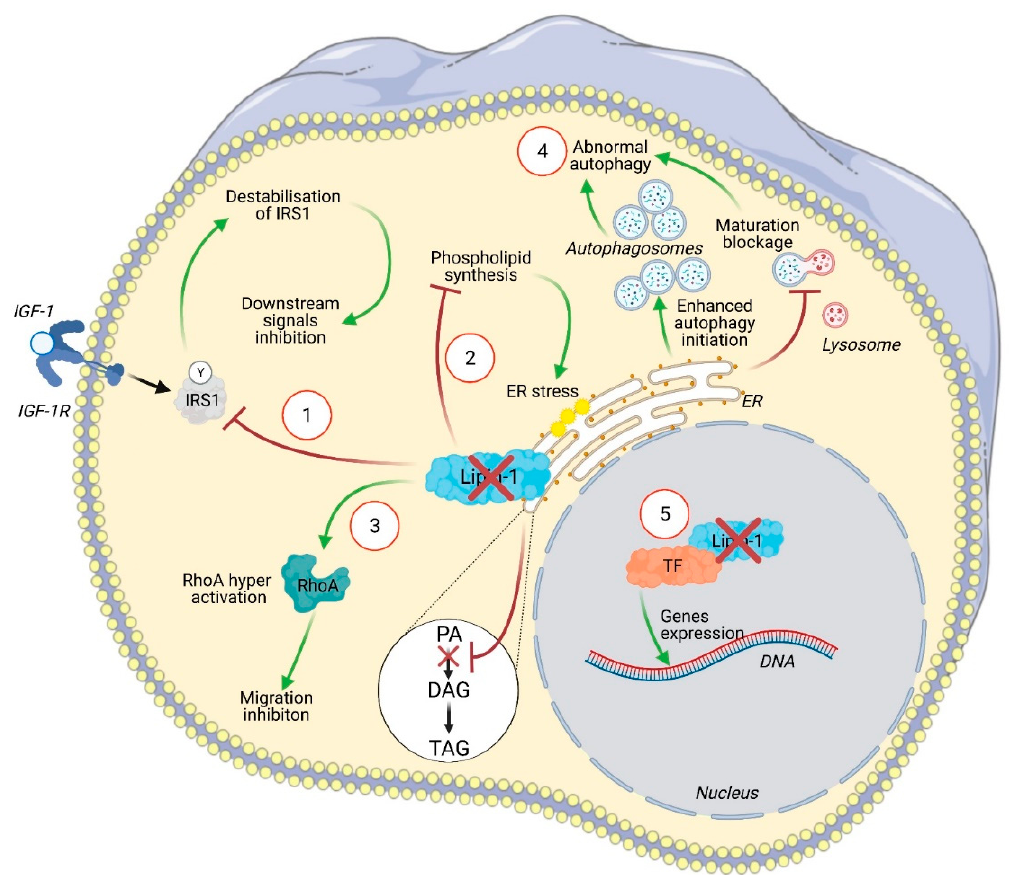
Figure 2. Illustration of the intracellular signaling pathways affected by lipin-1 silencing in cancer cells. In (1), insulin receptor substrate 1 (IRS1) is no longer stabilized by lipin-1 leading to an inhibition of Raf-1 and of its downstream targets including c-fos and AP-1. Lipin-1 silencing altered phospholipids synthesis (2). This activates the unfolded protein response (UPR) pathway and leads to endoplasmic reticulum (ER) stress. The increased concentration of phosphatidic acid (PA) due to the lack of lipin-1 activity can activate RhoA and inhibits cell migration (3). Lipin-1 depletion enhanced autophagy initiation, as indicated by enhanced LC3 and ULK phosphorylation, while a blockage of autophagosome maturation was observed, likely related to a lack of diacylglycerol (DAG). This leads to autophagosome accumulation (4). The precise contribution of lipin-1 transcriptional regulator activity to cancer cell phenotype has not yet been specifically addressed